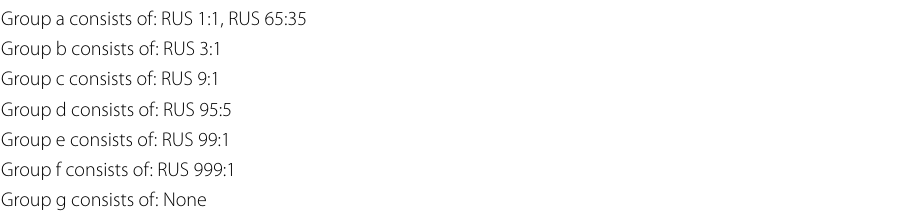
Table 16 HSD groupings of sampling ratios after 2-factor ANOVA where classifier and sampling ratio are factors; groups are by performance in terms of AUC